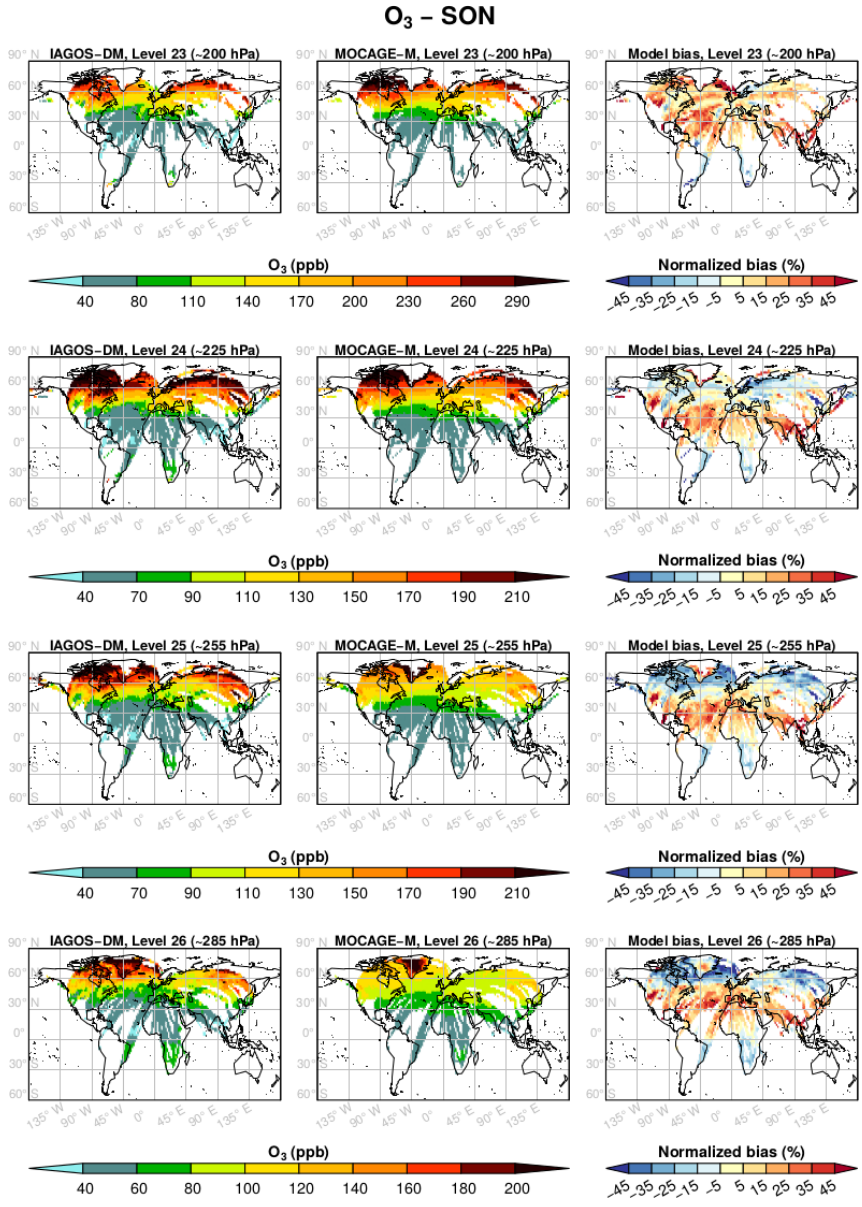
Figure A4. As Fig. 3 for boreal